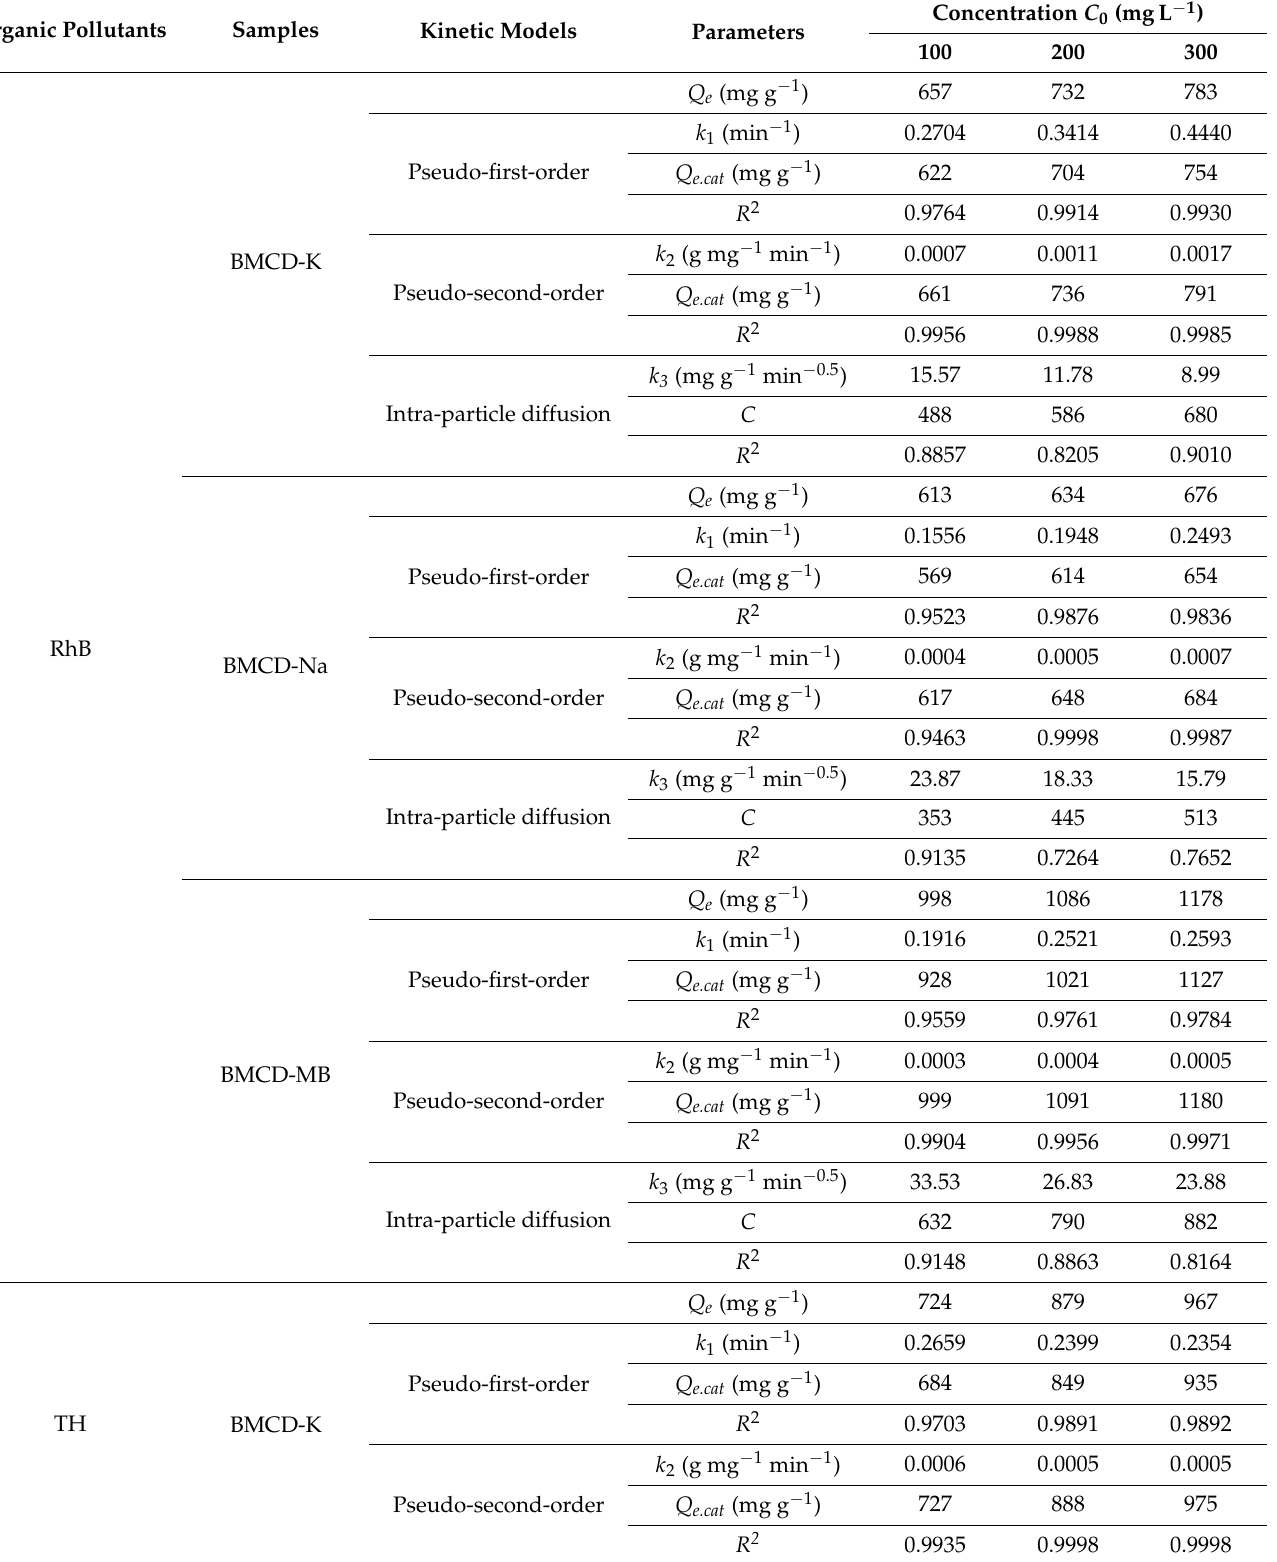
Table 2. Fitting parameters of adsorption kinetic models for RhB and TH at 303